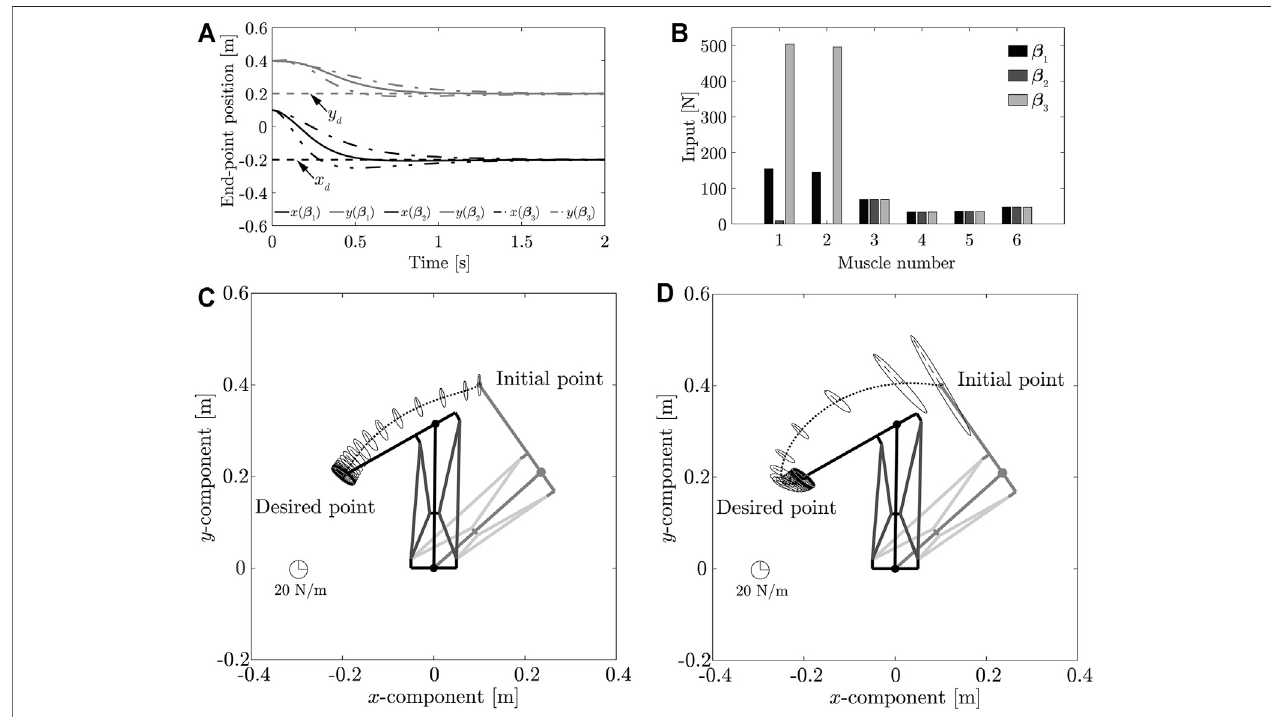
FIGURE 6 | (A) Transient response of end-point position as a function of arbitrary vector value. (B) Comparison of control inputs obtained using different arbitrary vectors. (C) Loci of end-point positions and end-point stiffness ellipsoid in task space obtained using arbitrary vector β 2 . (D) Loci of end-point positions and end-point stiffness ellipsoid in task space obtained using arbitrary vector β 3